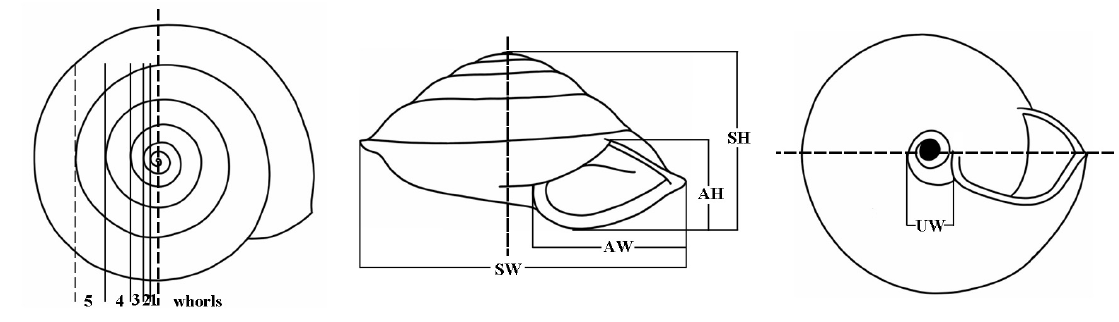
Fig. 1. Schematic drawings of shell indicating how the number of whorls was counted and how the measurements were taken. Abbreviations: AH = aperture height; AW = aperture width; SH = shell height; SW = shell width; UW = umbilicus